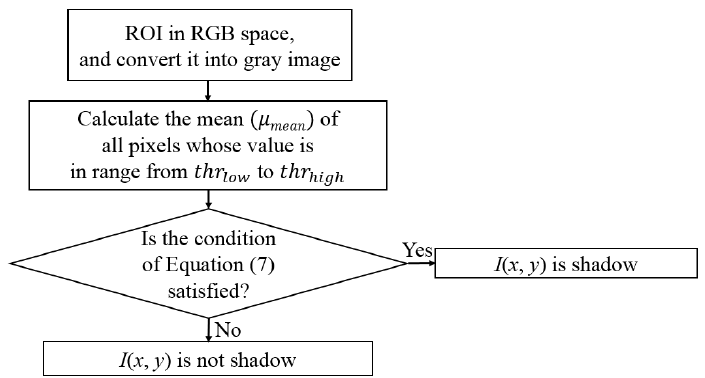
Figure 7. Flowchart for determining shadow for feature 2.